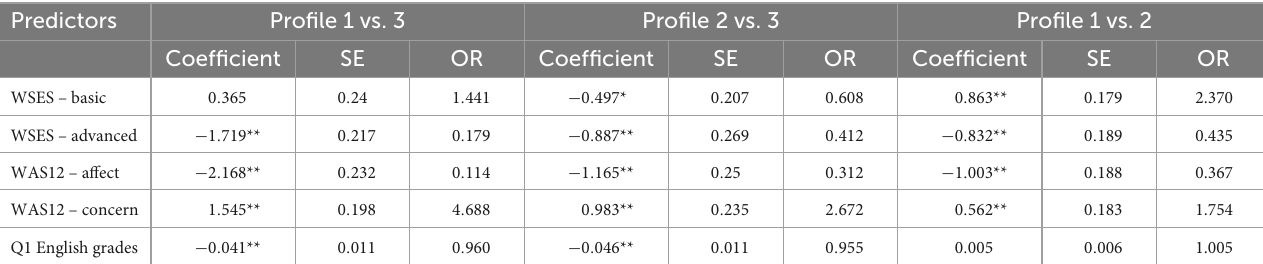
TABLE 9 Predictor coefficients and odds ratios for WSES and WAS-12 latent factor scores and first quarter English grades. Predictors